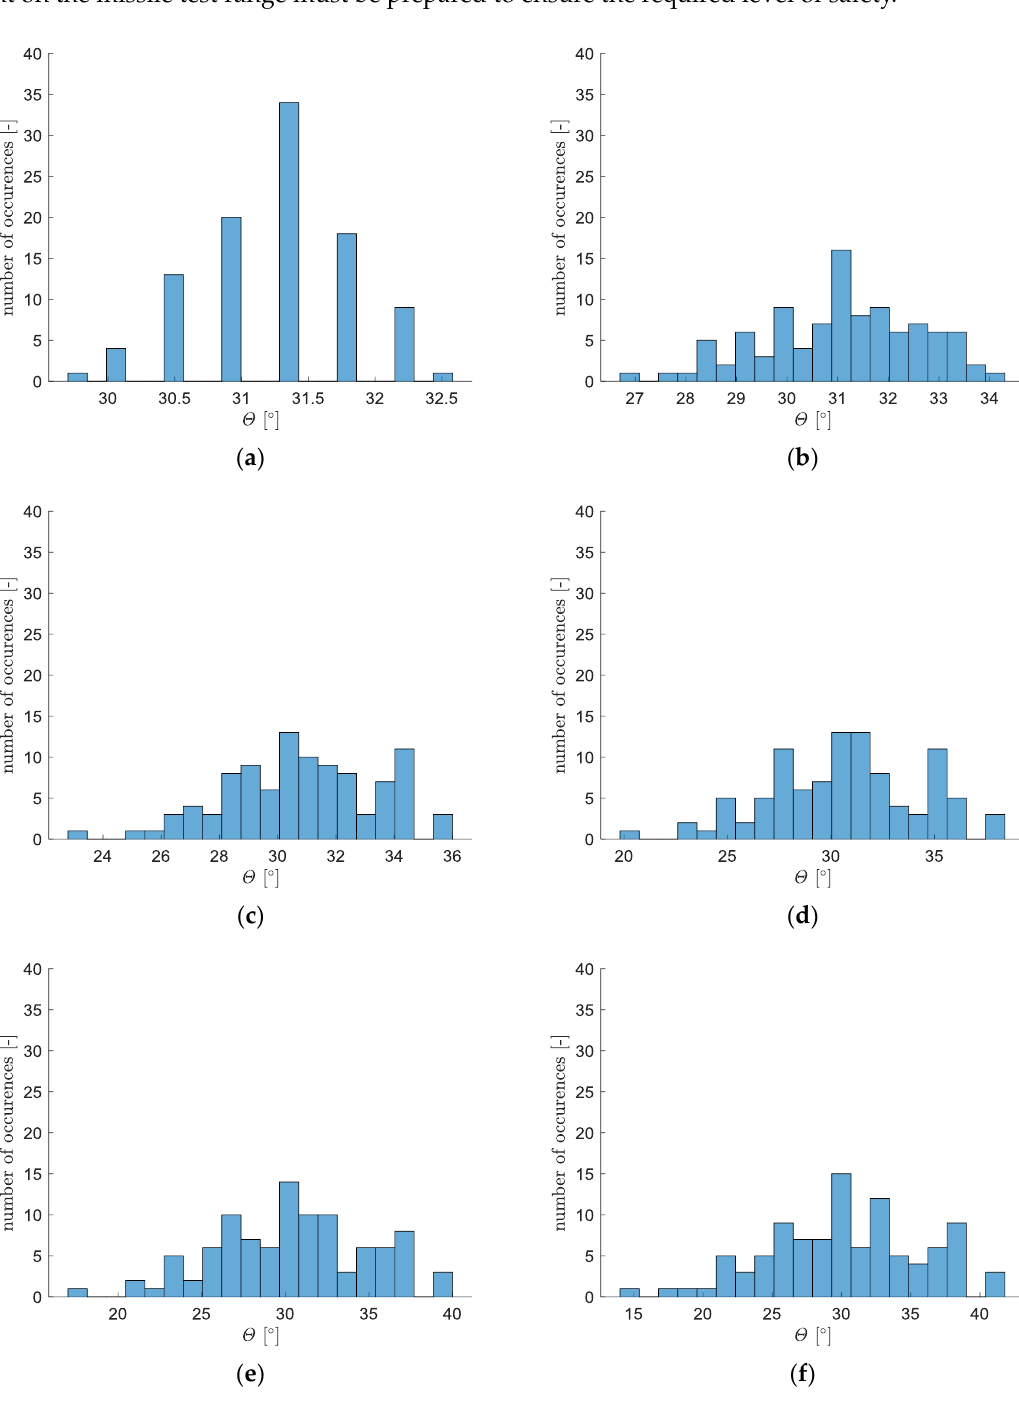
Figure 18. Projectile pitch angles histograms (3 s of flight) for various τ 1 , τ 2 , τ 3 standard deviations: ( a ) 0.001 s; ( b ) 0.0003 s; ( c ) 0.005 s; ( d ) 0.007 s; ( e ) 0.009 s; ( f ) 0.011 s.